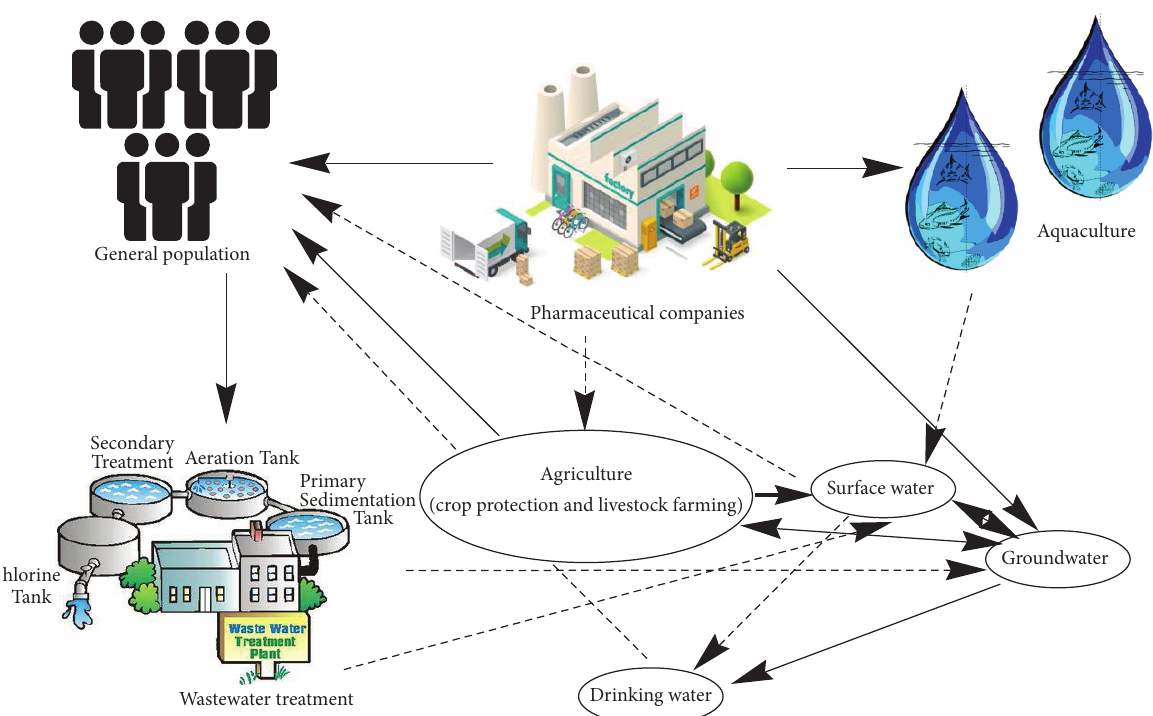
Figure 1: Routes of antifungal drugs into environmental